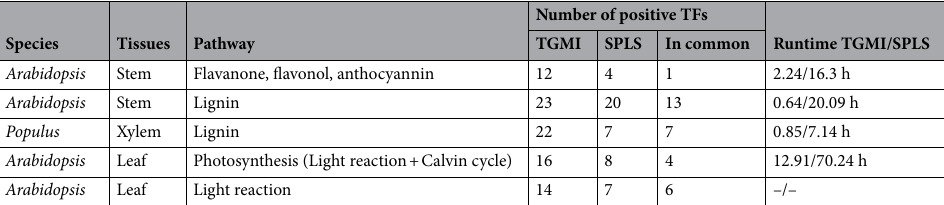
Table 1. Summary of identifying pathway regulators using triple-gene mutual interaction (TGMI) and sparse partial least squares (SPLS) in the top 50 transcription factors that have the highest connectivity to pathway genes. *These computing times were measured on Unix Intel(R) Xeon(R) CPU X5460 @ 3.16 GHz, with 2 physical ID, 4 cpu cores, 8